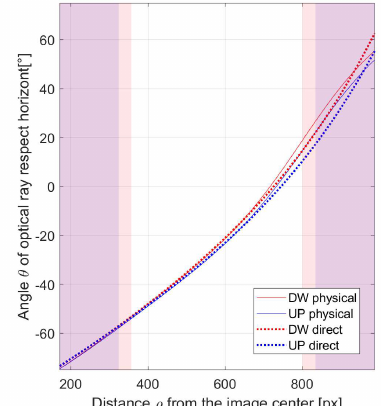
Figure 9 Angle of the optical ray as a function of the (cid:2251) distance from the center of the camera model for the optical head and both the models considered (direct and